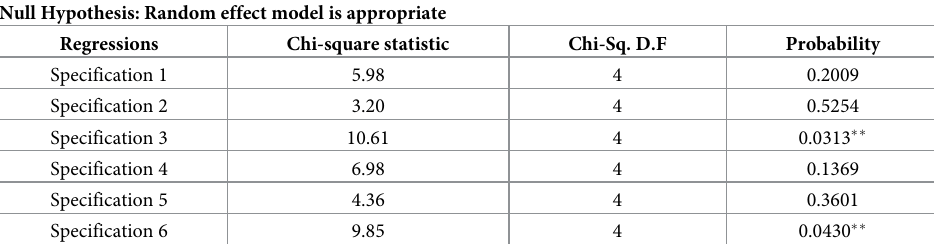
Table 3. Hausman test results for indirect impact through human capital.